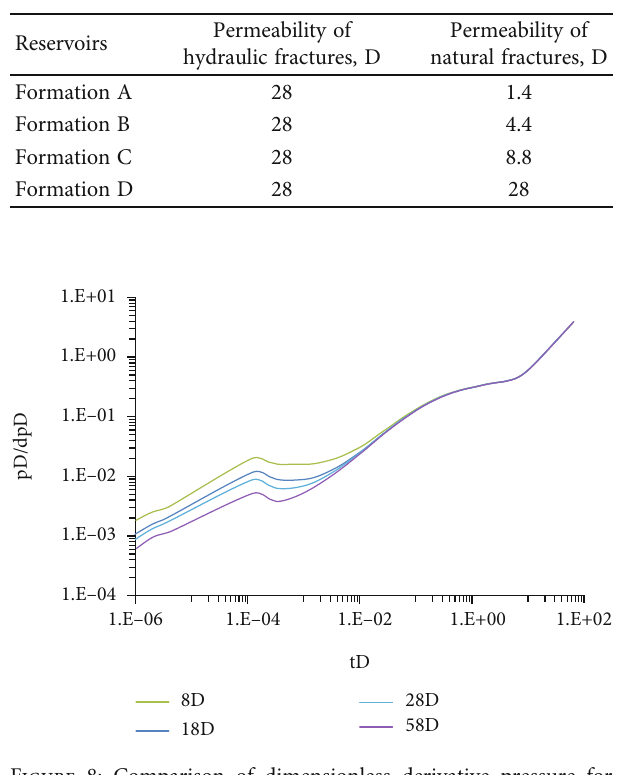
Figure 8: Comparison of dimensionless derivative pressure for four cases.